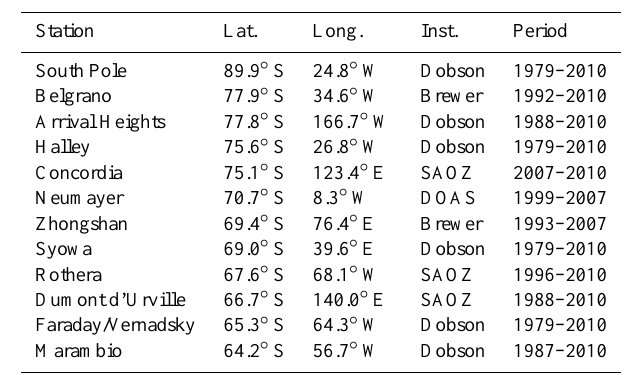
Table 1. Antarctic stations and their latitude (Lat.), longitude (Long.), type of instrument (Inst.), and observation period (Period) considered in this study.